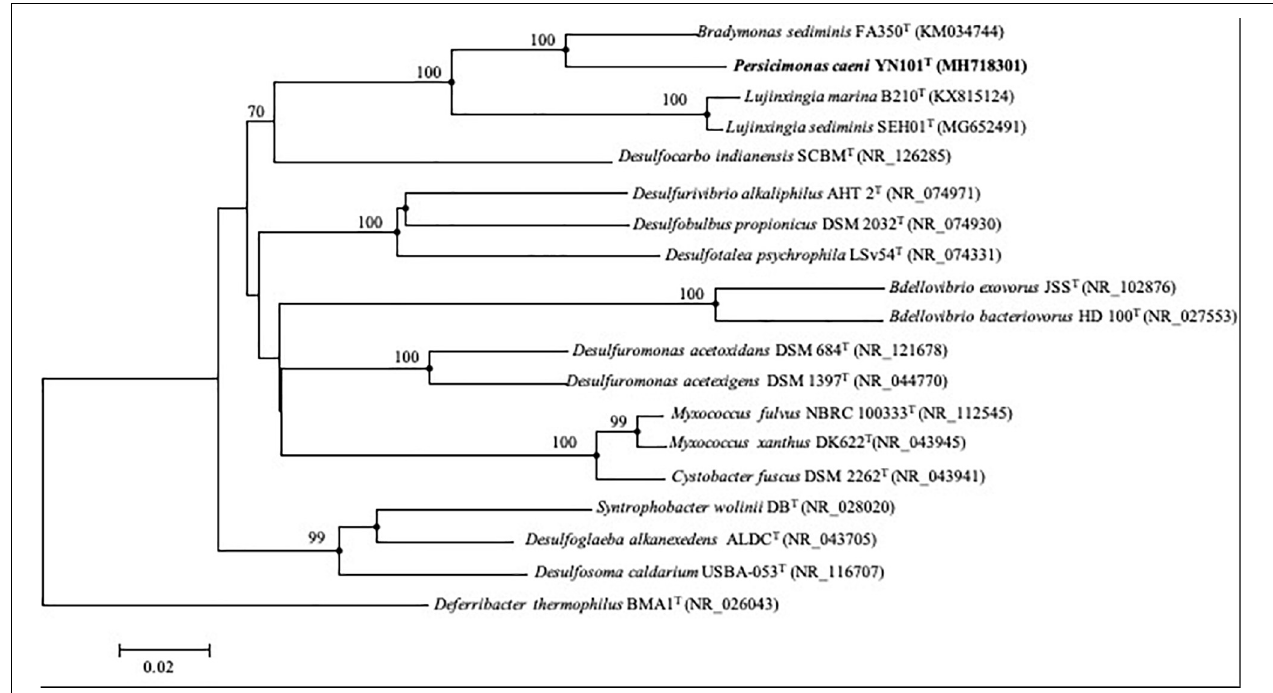
FIGURE 1 | Phylogenetic tree constructed from 16S rRNA gene sequences, showing the position of strain YN101 T and type strains of related taxa within the phylum Proteobacteria . The tree was constructed using the neighbor-joining algorithm. The filled circles indicate that the corresponding nodes were also found in the trees generated with the maximum-likelihood and maximum-parsimony algorithms. Bootstrap values (expressed as percentages of 1000 replications) > 70% are shown at branch points. GenBank accession numbers of 16S rRNA gene sequences are given in parentheses. Deferribacter thermophilus BMA1 T (NR_026043) was used as an outgroup. Bar, 0.02 substitutions per nucleotide